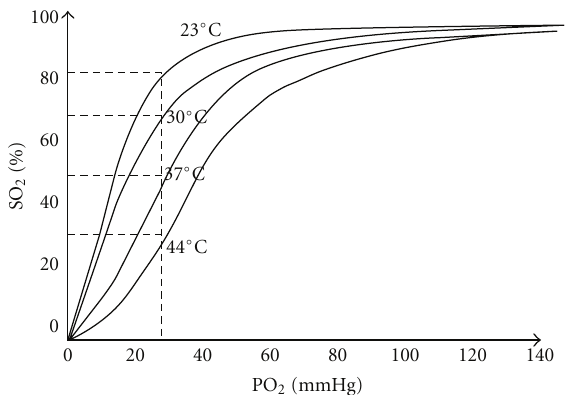
Figure 2: Relationship between oxygen partial pressure (PO 2 ) and oxygen saturation of hemoglobin (SO 2 ). Hypothermia increases the a ffi nity of hemoglobin for oxygen, according to Tremey and Vigu´e